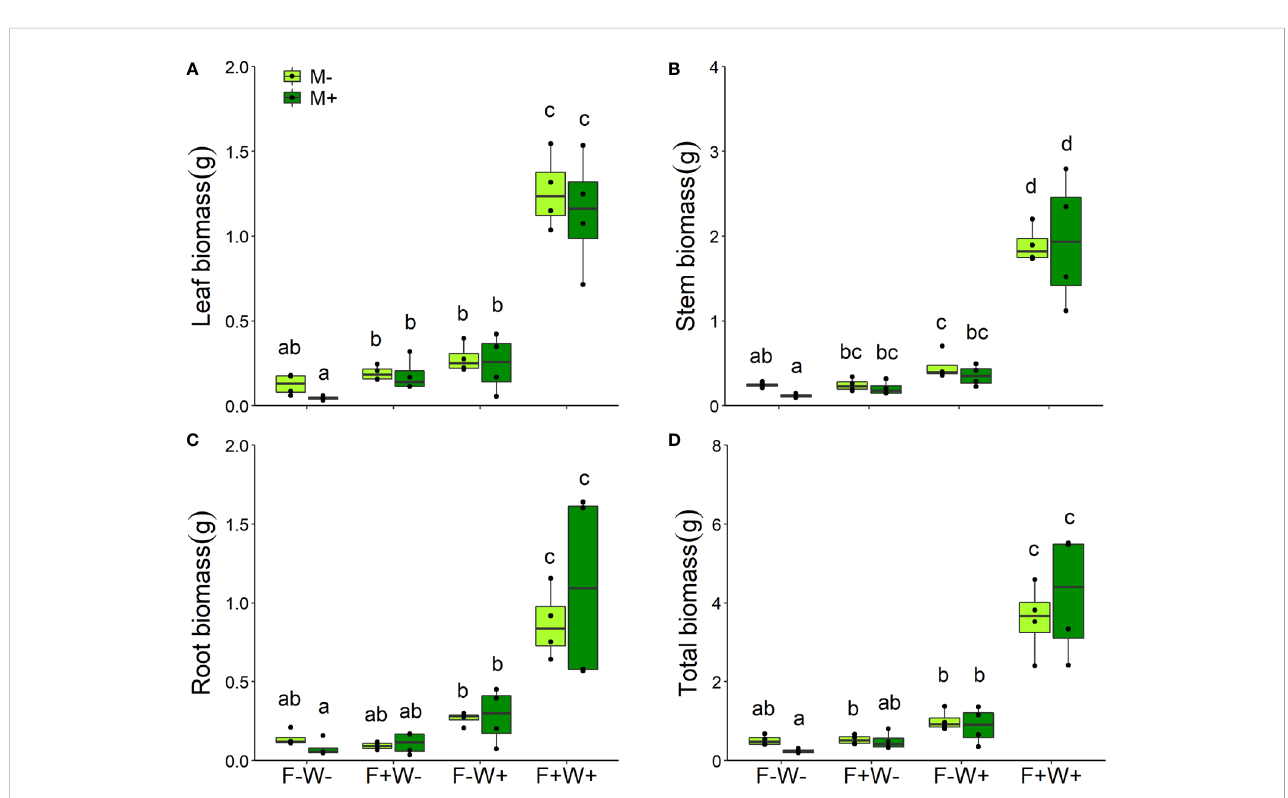
FIGURE 2 Leaf (A) , stem (B) , root (C) biomass and total mass (D) of Artemisia ordosica plants inoculated with AMF species Funneliformis mosseae (M+) or not (M-) and grown under four different combinations of fertilization (F-: no fertilization; F+: fertilization) and water addition (W-: low soil water; W+: high soil water) treatments. Light symbols: plants received no AMF; dark symbols: plants inoculated with AMF. The boxplot shows the 25% and 75% quartiles, the median, whiskers (1.5 times the interquartile range) and the outliers of the samples, and the points in the plot area represent different replicates of the corresponding treatment. Boxplots sharing one or more identical letters are not signi fi cantly different based on Tukey ’ s post hoc test. Statistics are shown in Table 1.